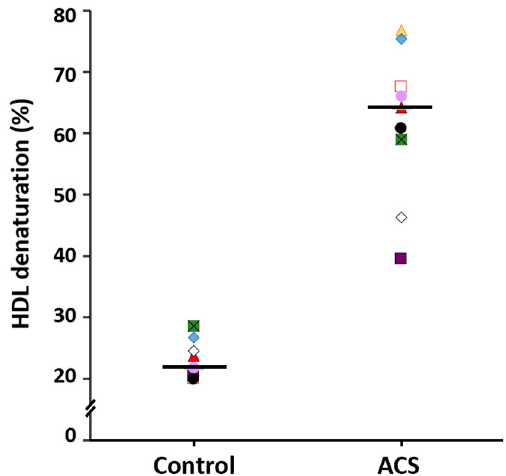
Figure 5. Percentage of HDL denaturation after 8 h of incubation with urea 8 M, in ACS patients ( n = 9) and controls ( n = 9) matched by HDL-cholesterol plasma levels. Same symbols represent the paired controls and ACS patients. Horizontal bar represents the median of the subgroup.